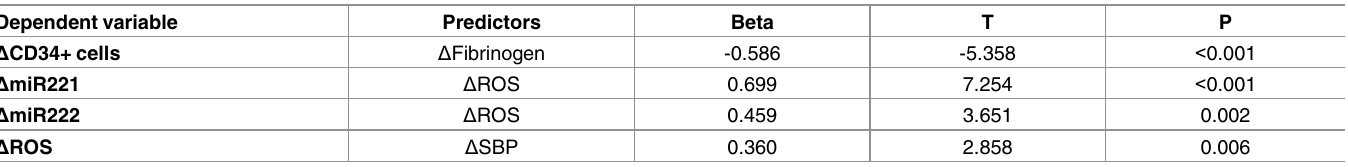
pendent mediated effects.